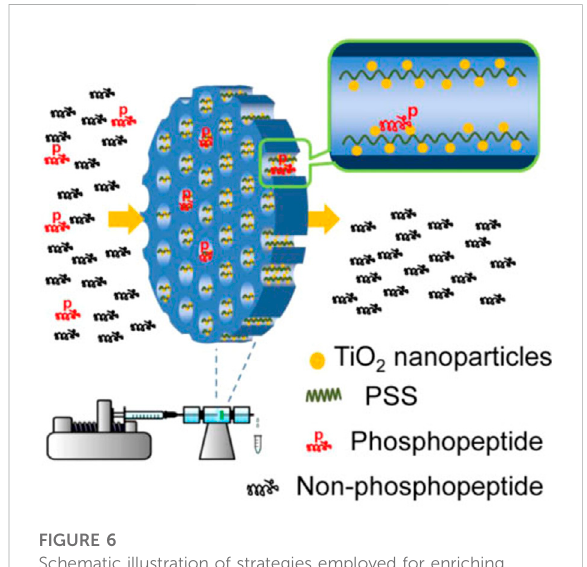
Schematic illustration of strategies employed for enriching phosphopeptides. Reproduced from ref 69. Copyright 2013 American Chemical Society.